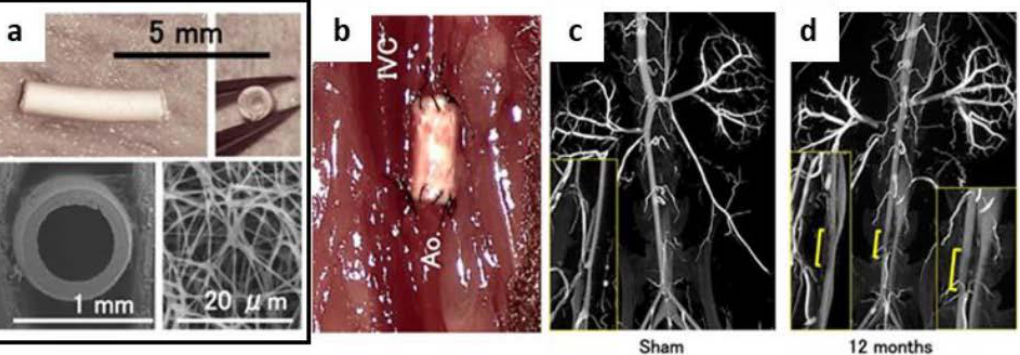
Figure 17. ( a ) Structure of TEVG. Implanted TEVG was composed of biodegradable electrospun PLA nanofibers with a length of approximately 3 mm and an inner luminal diameter of 500 – 600 μm. Scanning electron microscopy (SEM) demonstrates macro - and micro-arrangement of graft. ( b ) TEVG after surgical implantation (IVC: inferior vena cava; Ao: aorta). ( c , d ) High-resolution post-mortem microCT angiography at 12 months post-implantation. The results indicated a smooth endoluminal surface and absence of aneurysmal dilatation or stenosis. Yellow bar indicates the approximate location of the vascular graft. TEVG resembles native aorta on microCT throughout the 12 month-experiment; ( n = 5 in each group), reproduced from [147], distributed under the terms of Creative Commons Attribution License.